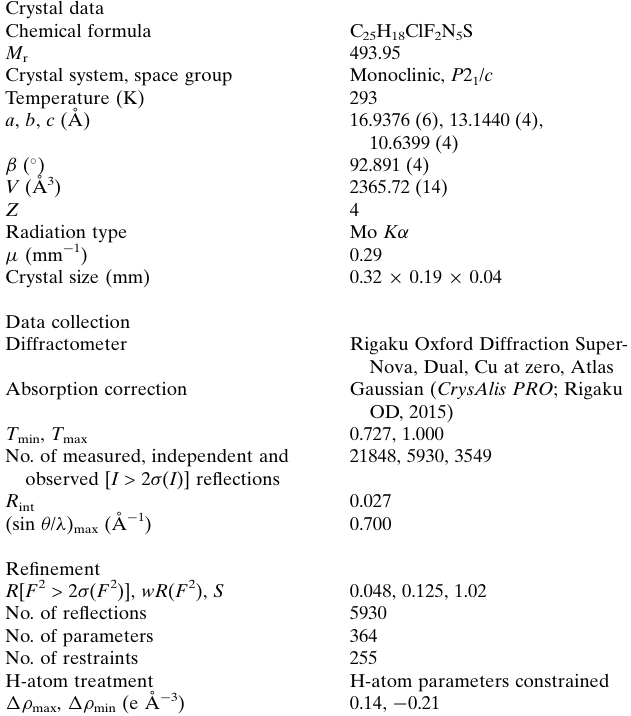
Table 1 Hydrogen-bond geometry (A˚ , (cid:2) ).